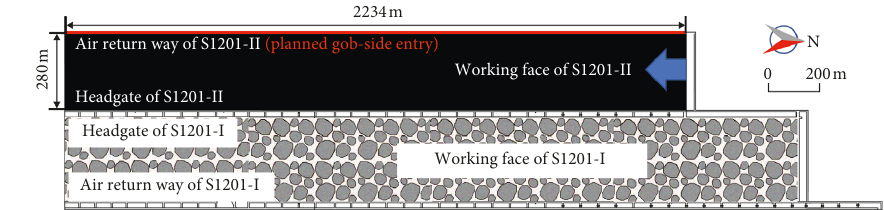
Figure 1: Roadway layout of the S1201-II working face.